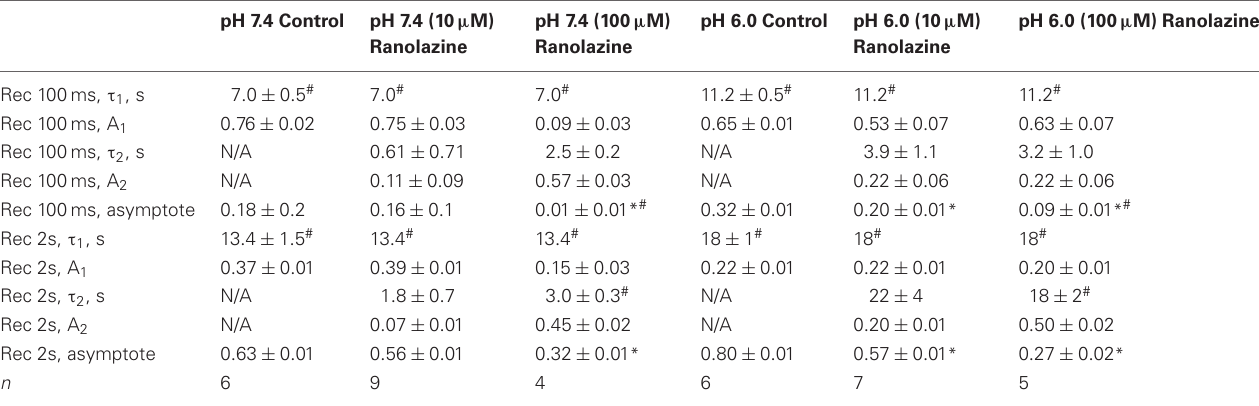
Table A7 | Slow inactivation